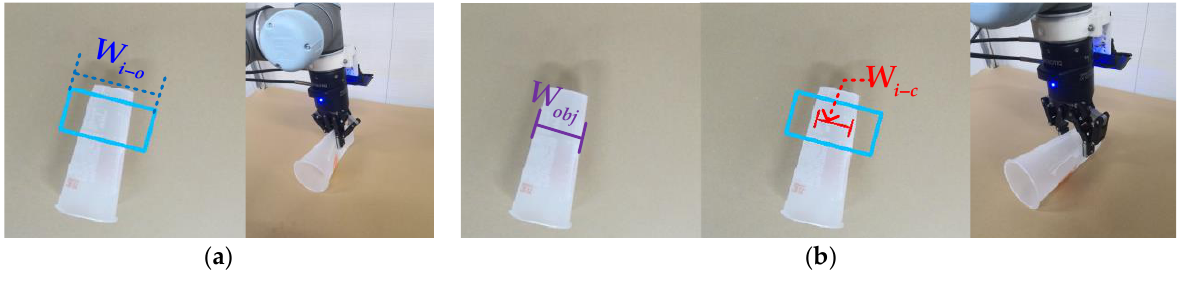
Figure 7. Robot close grasping test results. ( a ) The conventional grasping method directly closing; it easily broke the objects; ( b ) our grasping method with adaptive closing width, which is fine for objects. The blue rectangle refers to the opening width when the gripper approaches the object, and the red “I” represents the closing width when the gripper picks up the object.